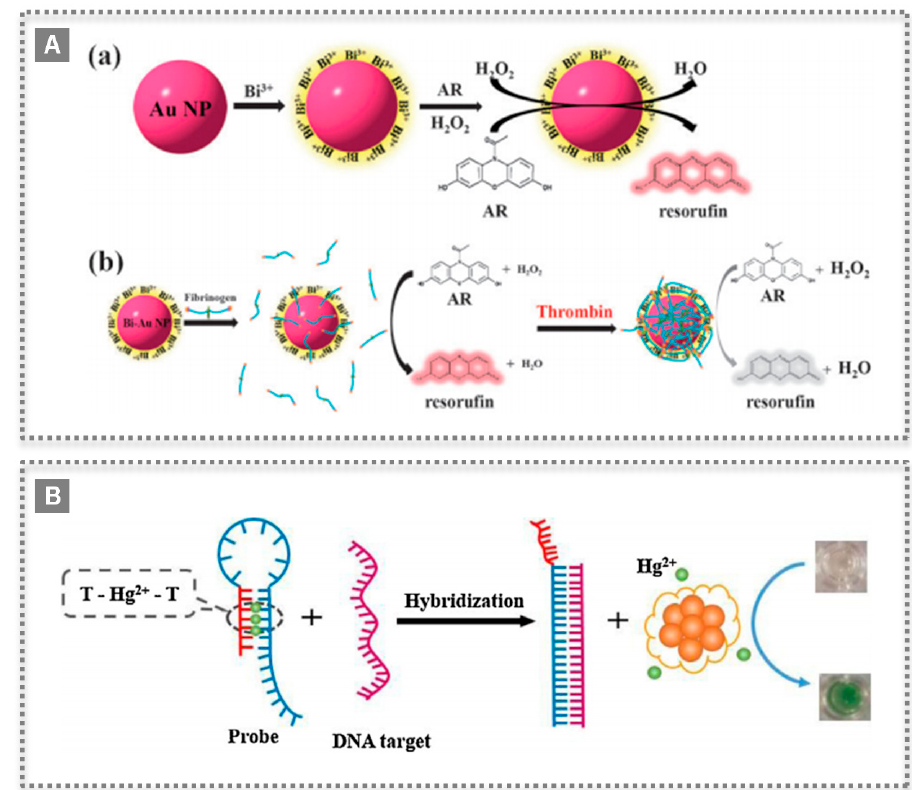
Figure 5. Nanozyme bioconjugates for sensing applications: ( A ) Scheme of bismuth-gold nanopar- ticles preparation and peroxidase-like catalyzing mechanism for reaction with Amplex Red (AR) ( a ), and further modification with fibrinogen as probe for detection of thrombin ( b ). (Reproduced with permission [25] Copyright 2012, The Royal Society of Chemistry); ( B ) Colorimetric biosensor based on oxidase-like activity of bovine serum albumin-protected silver clusters, which is switched on selectively by mercury ions and applied to detect DNA. (Reproduced with permission [30], Copyright 2015, Elsevier B.V.)